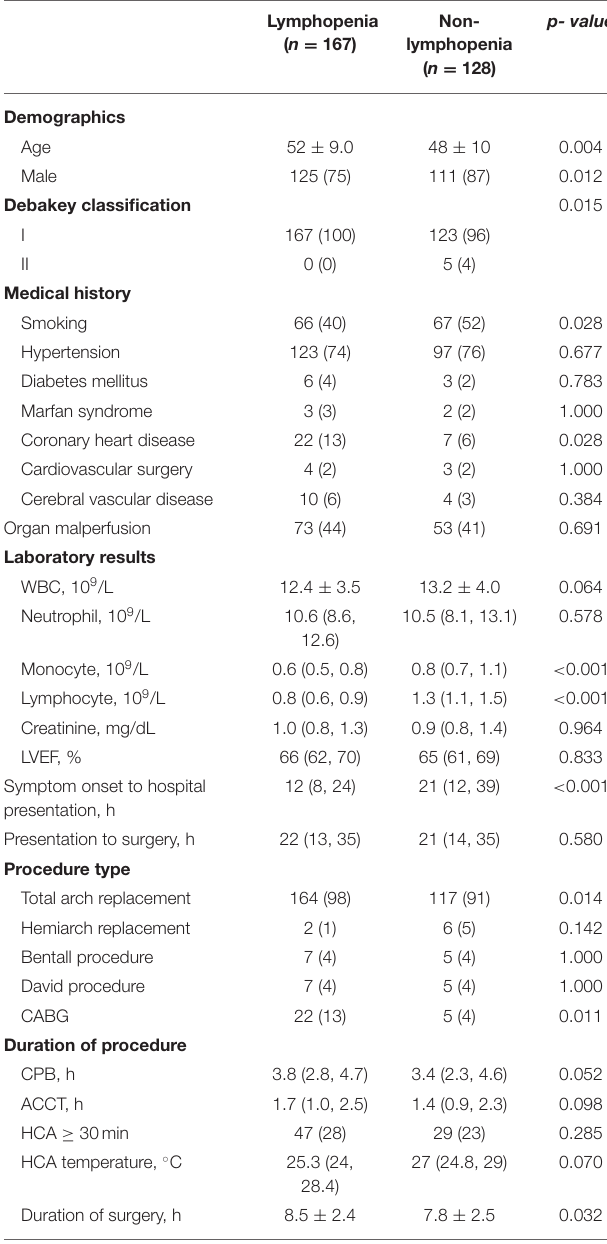
TABLE 1 | Demographic and clinical characteristics of patients with lymphopenia and